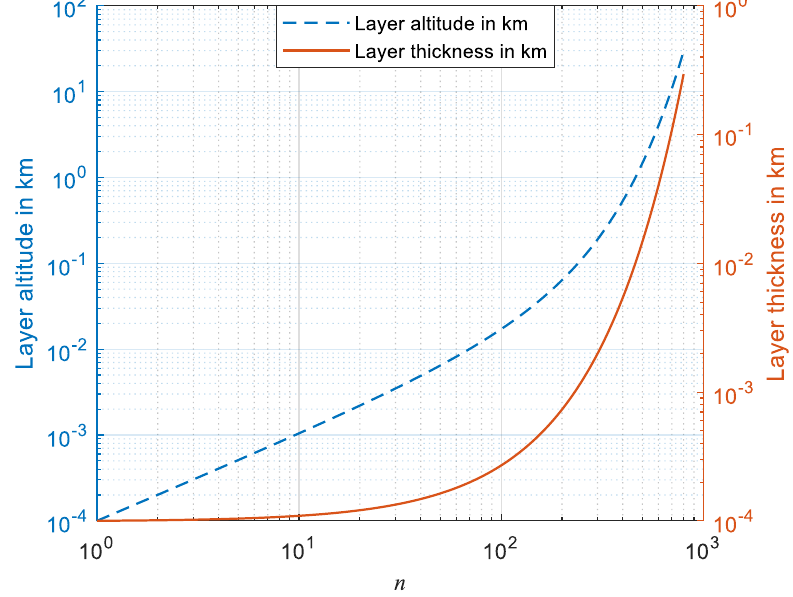
Figure 8. Atmospheric layer altitude and thickness variation with layer number.